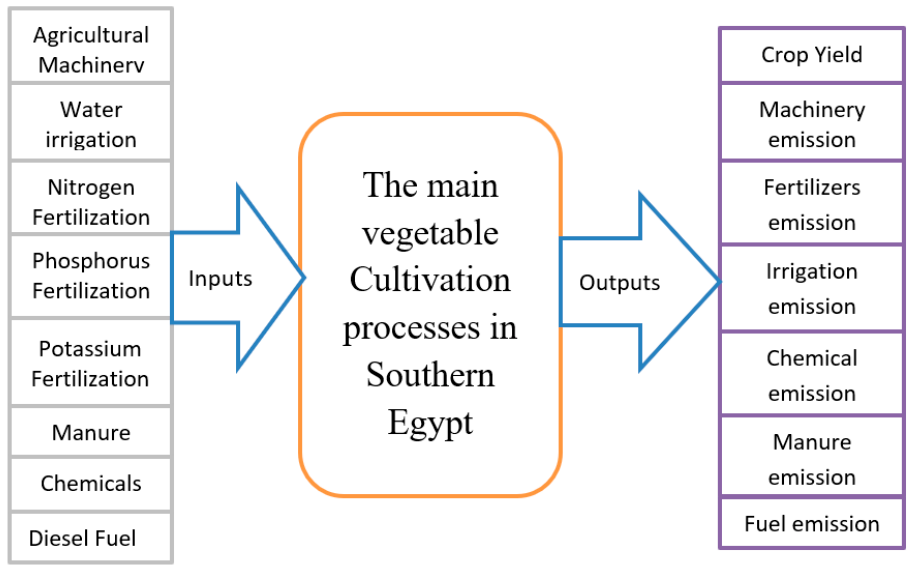
Figure 1. System boundary of cultivation processes (onion, potato and tomato).